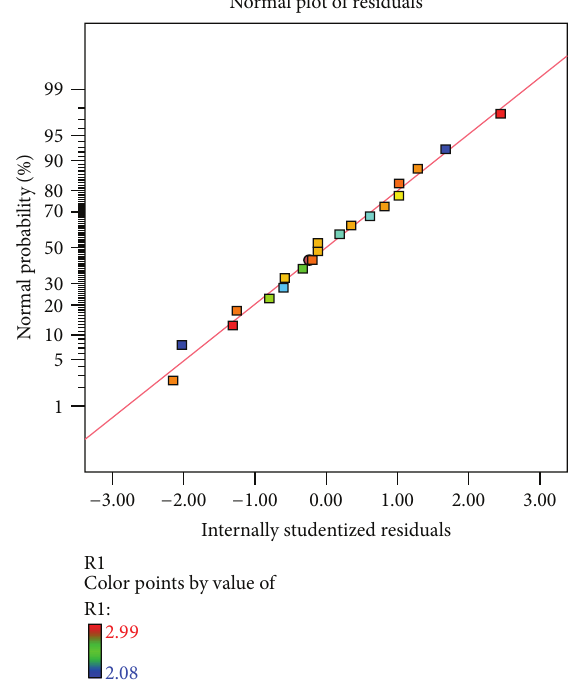
Figure 2: Normal probability plot of residuals for specific wear rate (mm 3 /Nm).